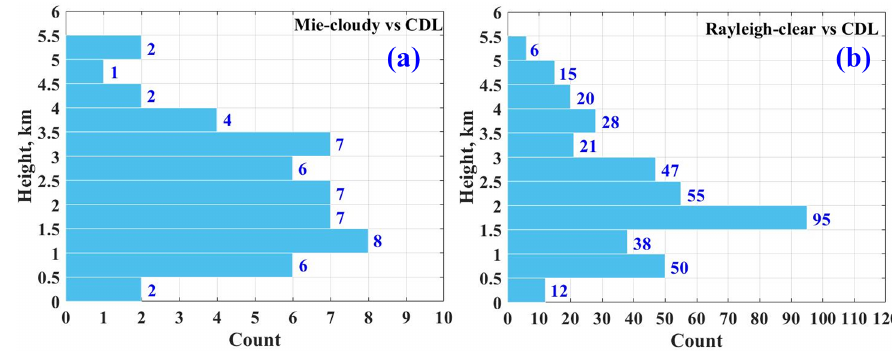
Figure 9. Counts of data pairs at different height ranges of (a) Mie-cloudy vs. CDL and (b) Rayleigh-clear vs. CDL.